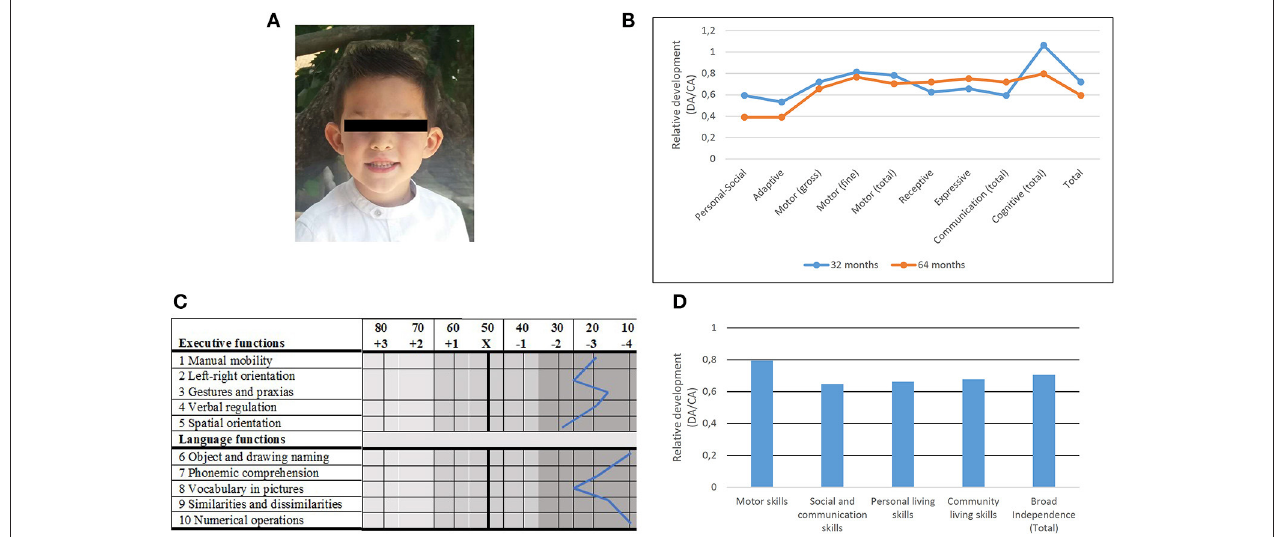
FIGURE 1 | Main physical and cognitive findings in the proband. (A) Facial picture illustrating some of the dysmorphological features found in the proband. Written informed consent was obtained from the parents of the child for the publication of this image. (B) Developmental profiles of the proband at 2 years and 8 months (blue) and at 5 years and 4 months (orange) according to the Battelle Developmental Inventories. In order to make more reliable comparisons, the resulting scores are shown as relative values referred to the expected scores according to the chronological age of the child. DA, developmental age; CA, chronological age. (C) Developmental profile of the proband at age 5 years and 6 months according to Luria-Nebraska Neuropsychological Battery for Children (LNNB-C). DA, developmental age; CA, chronological age. (D) Developmental profile of the proband at age 5 years and 6 months according to the Inventory for Client and Agency Planning